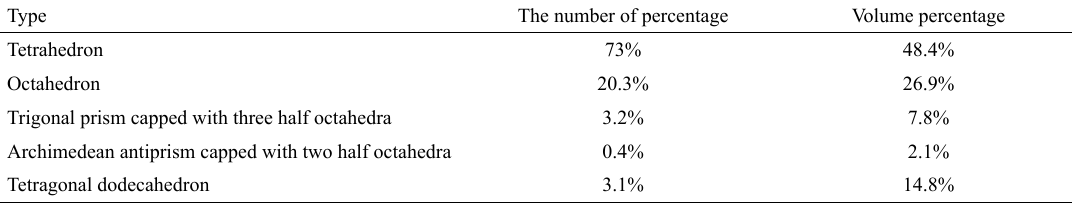
Table 1. The percentage of five Bernal polyhedrons.